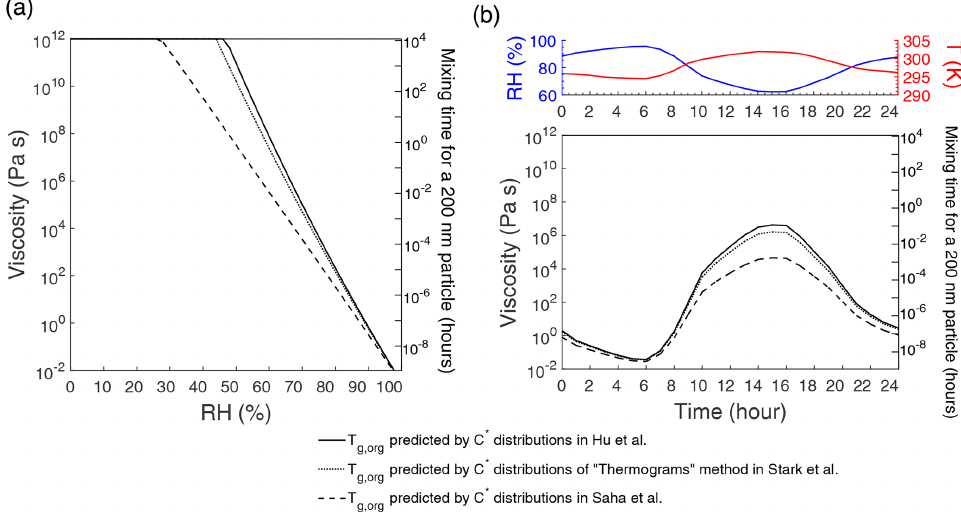
Figure 3. (a) Predicted viscosity of total OA measured during the SOAS campaign as a function of RH. (b) Diurnal variations of viscosity of total OA predicted employing the measured RH and T (Hu et al., 2016) during the SOAS campaign. T g , org values are calculated using the volatility distributions measured in Hu et al. (2016), Saha et al. (2017), and the Thermograms method in Stark et al. (2017). Characteristic mixing timescales of organic molecules with a radius of 10 − 10 m within 200nm particles are also shown on the right axis.